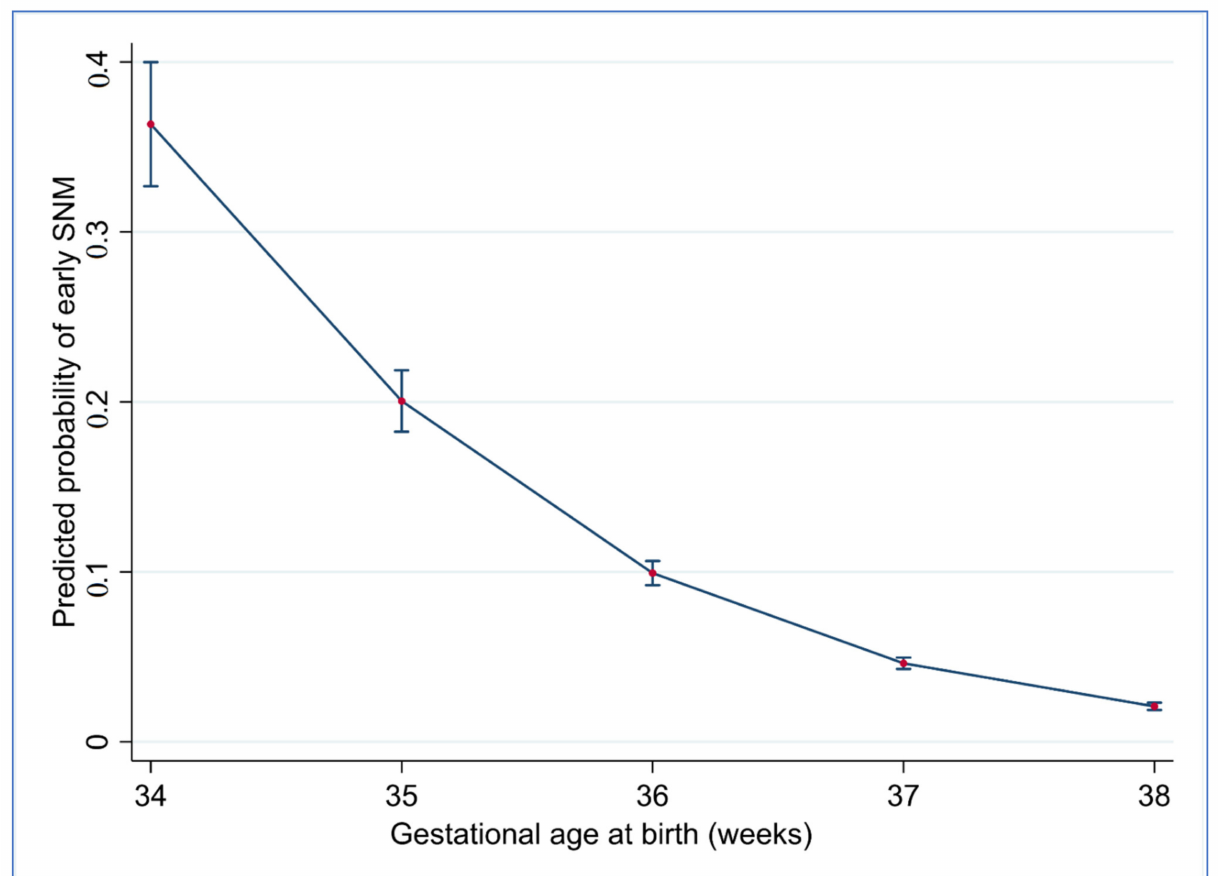
Figure 2. Adjusted predicted probability for early SNM by gestational